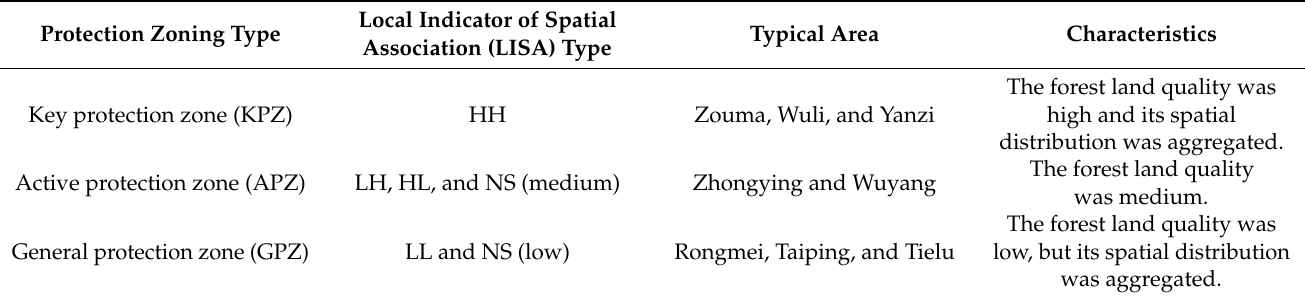
Table 4. Forest land protection zoning